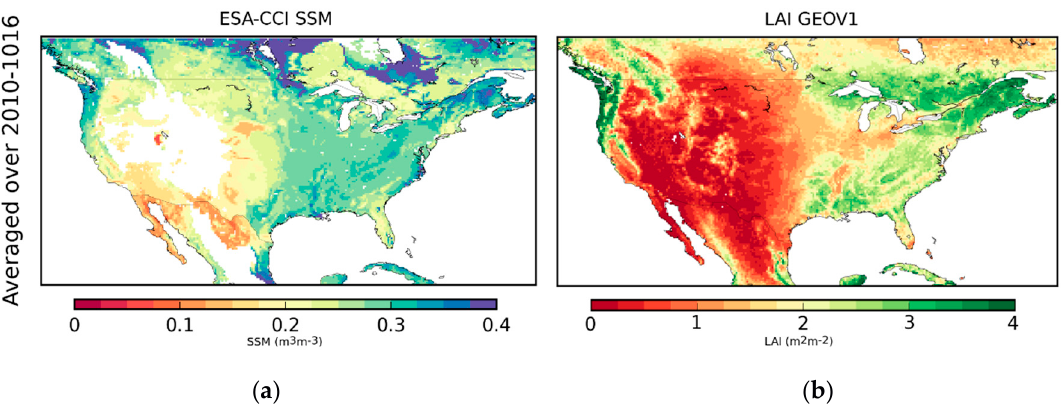
Figure 1. Averaged ( a ) surface soil moisture from the Climate Change Initiative project of ESA (for pixels with less than 15% of urban areas and with an elevation of less than 1500 m above sea level); ( b ) GEOV1 leaf area index from the Copernicus Global Land Service project (for pixels covered by more than 90% of vegetation) from 2010 to 2016. ESA CCI SSM—European Space Agency and Climate Change Initiative surface soil moisture; LAI—leaf area index.